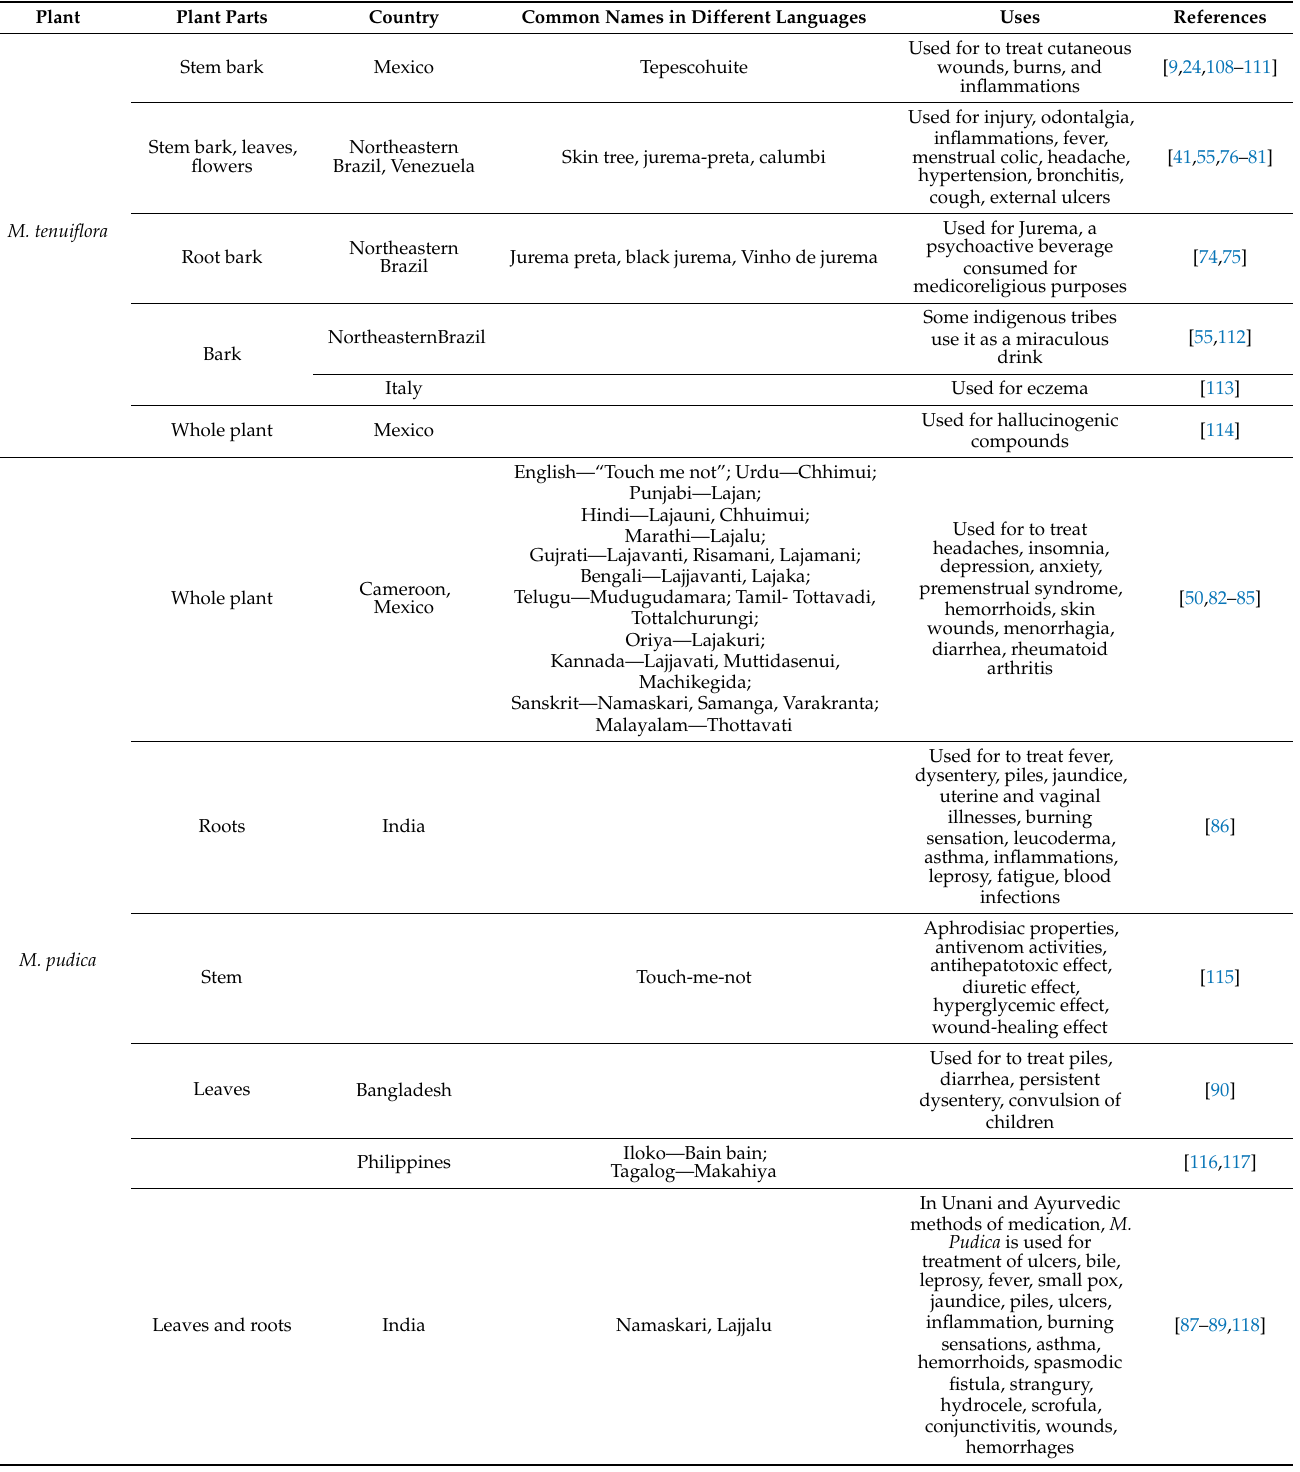
Table 1. Ethnotraditional uses of different species of the genus Mimosa